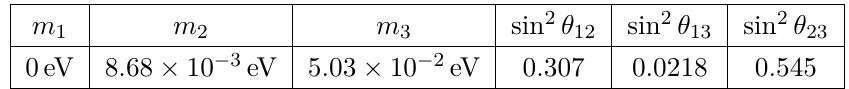
Table 1. Variables of the ν MSM model, light neutrino observables from the Particle Data Group 2020